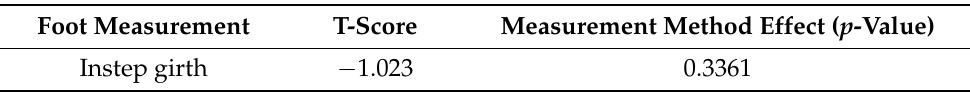
Table 6. Paired t -test for comparing the two measurement methods (MM, AM) of the instep girth measurement using the test dataset after applying linear regression.